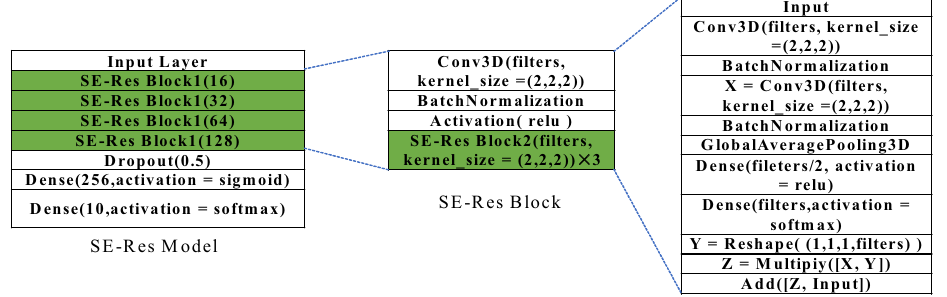
Figure 9. 3D SE-ResNet branch in the proposed architecture.